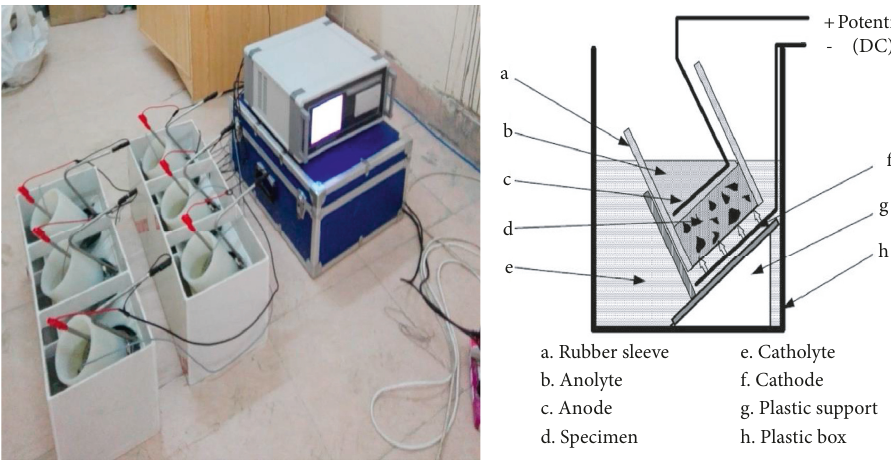
Figure 3: Chloride migration test apparatus and cross-sectional view of catholyte and anolyte. Table 4: Fresh properties of SCC.